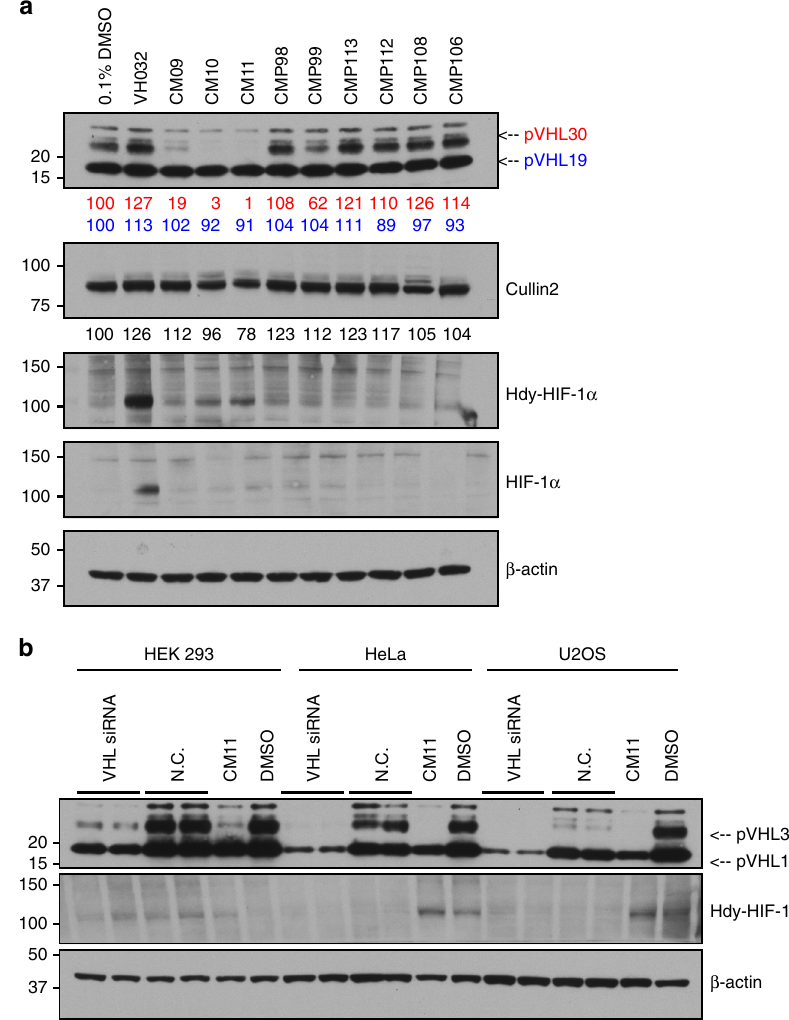
Fig. 4 Homo-PROTACs CM09, CM10 and CM11 induce selective knockdown of the long isoform of VHL. a HeLa cells were treated with 0.1% DMSO, VH032 (150 µ M) and 1 µ M of the indicated compounds for 10 h. Abundance of individual proteins was analyzed by western blotting using corresponding speci fi c antibodies accordingly after SDS-PAGE. The data demonstrated is a representative example of experiments performed in biological duplicates. b Different cells lines were treated with siRNA targeting VHL proteins or negative control siRNA (for 48 h), as well as with CM11 (1 µ M) or 0.1% v/v DMSO for 10 h. The bands observed to selectively disappear in the presence of CM09 – 11 are closely migrating isoforms of pVHL30 (see refs 52, 53 ). The data demonstrated is a representative example of experiments performed as four biological